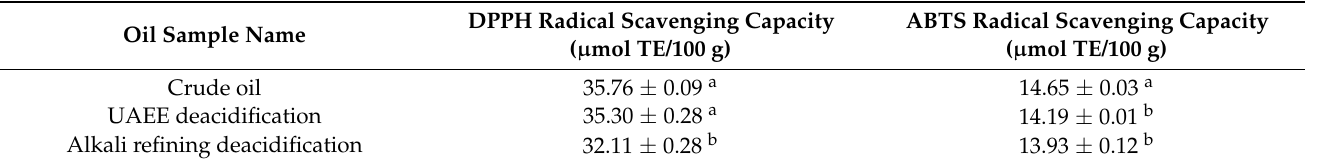
Table 6. Effect of deacidification methods on antioxidant activity of SSO in